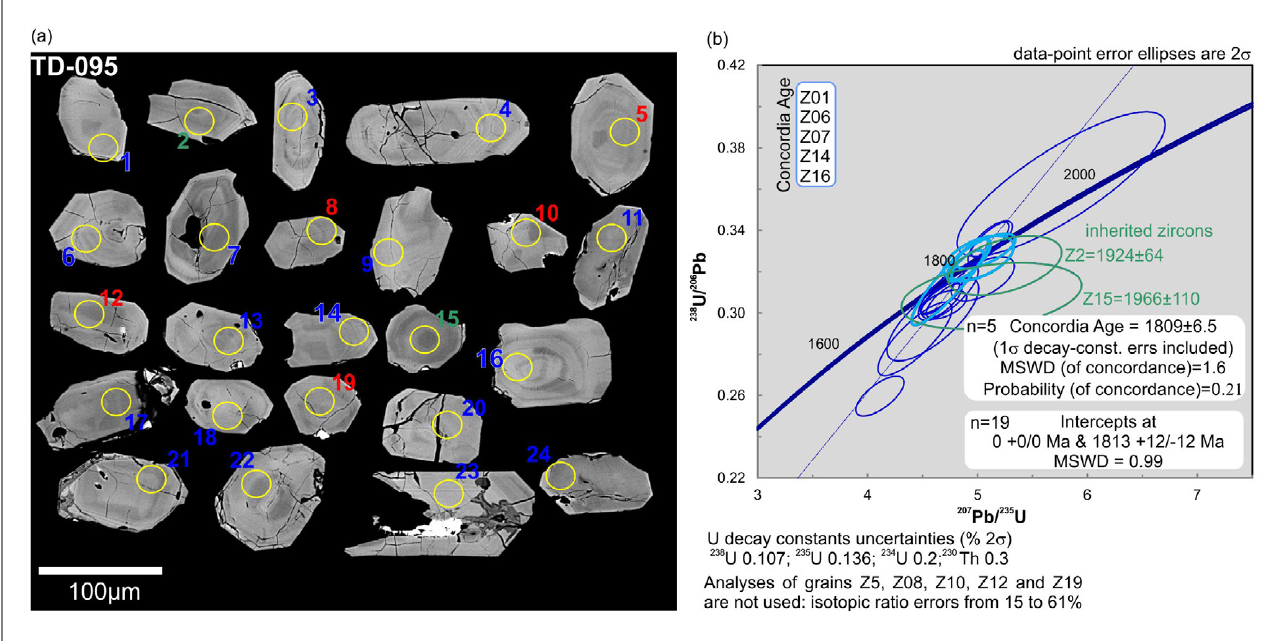
FIGURE 14 - (a) BSE image of zircons of a rhyodacite (sample TD-095) from the Colíder Group showing their morphological features, location and ID of pits; and (b) U-Pb concordia diagram and the upper intercept age calculated including the ages related to inherited zircons.